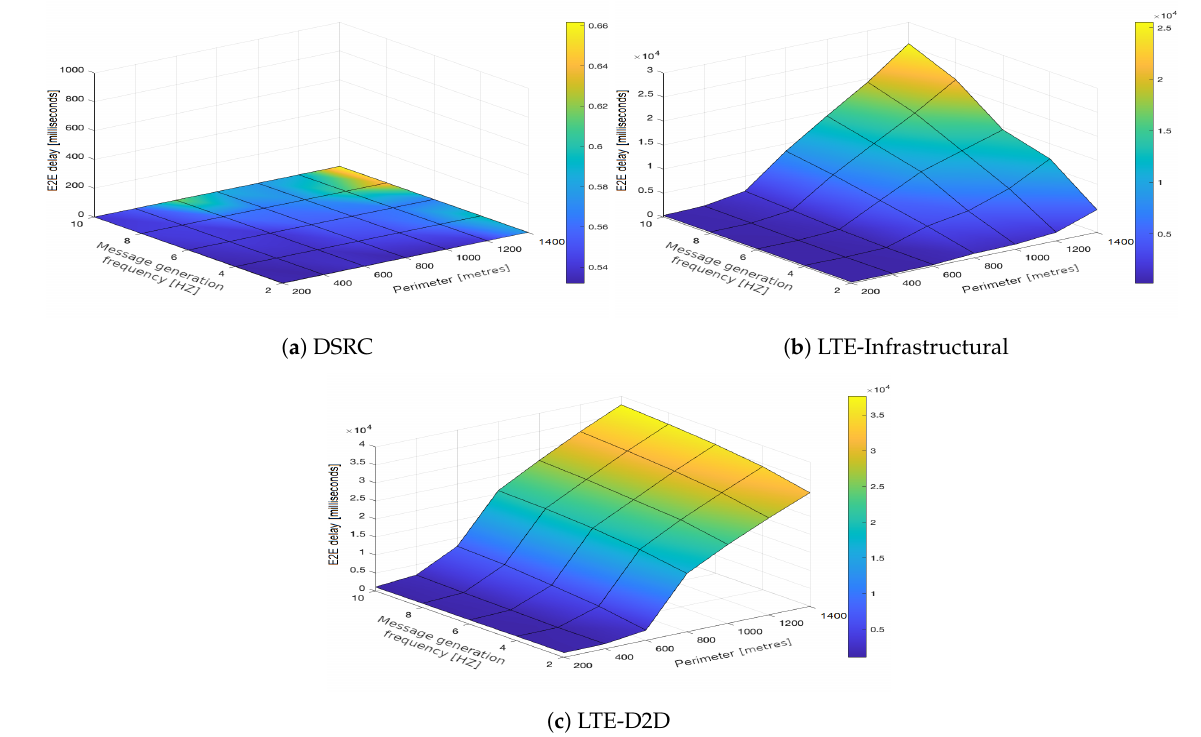
Figure 9. End-to-end delay obtained for the traffic intensity of 500 vehicles per hour.